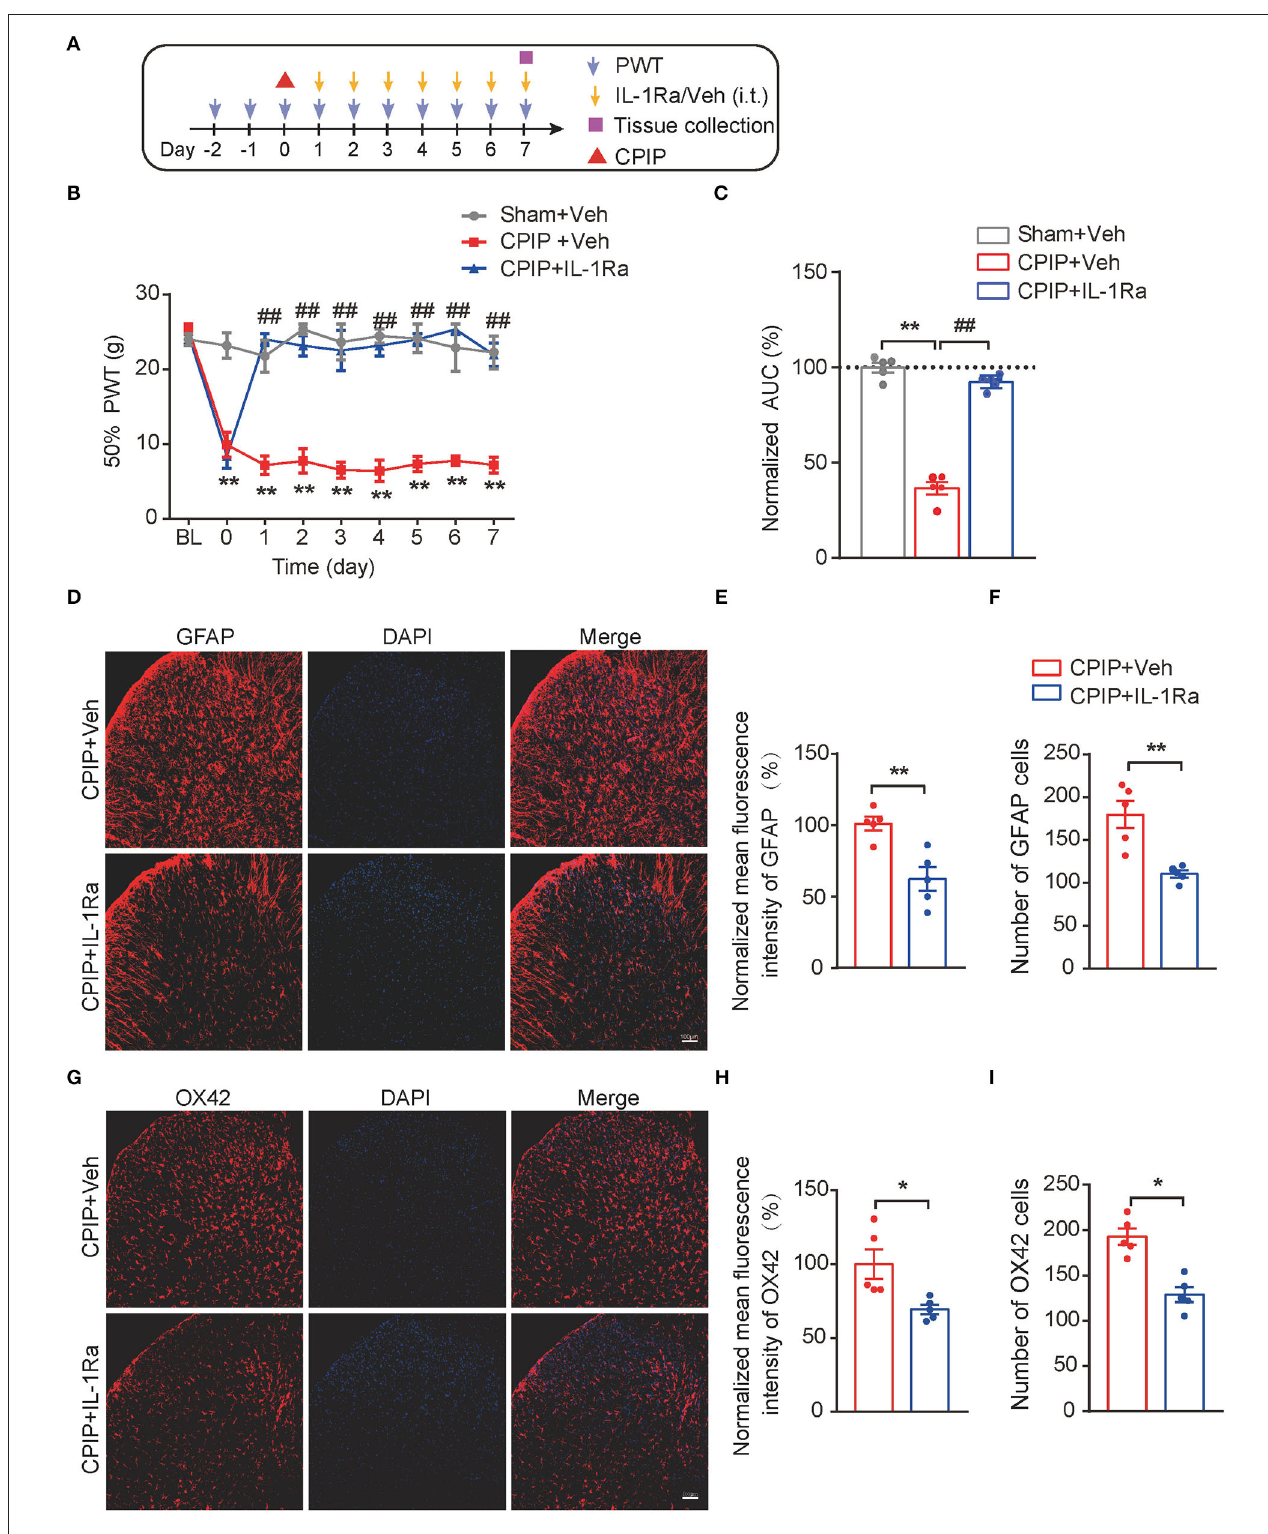
FIGURE 9 | Spinal blocking IL-1 β prevents mechanical allodynia and attenuates spinal glial over-activation in CPIP model rats. (A) Experimental protocol. (B) Time course showing the effect of intrathecal IL-1Ra (100 ng/rat/day) or vehicle (Veh 0.1% BSA in PBS) on mechanical allodynia of CPIP rats. (C) Normalized AUC